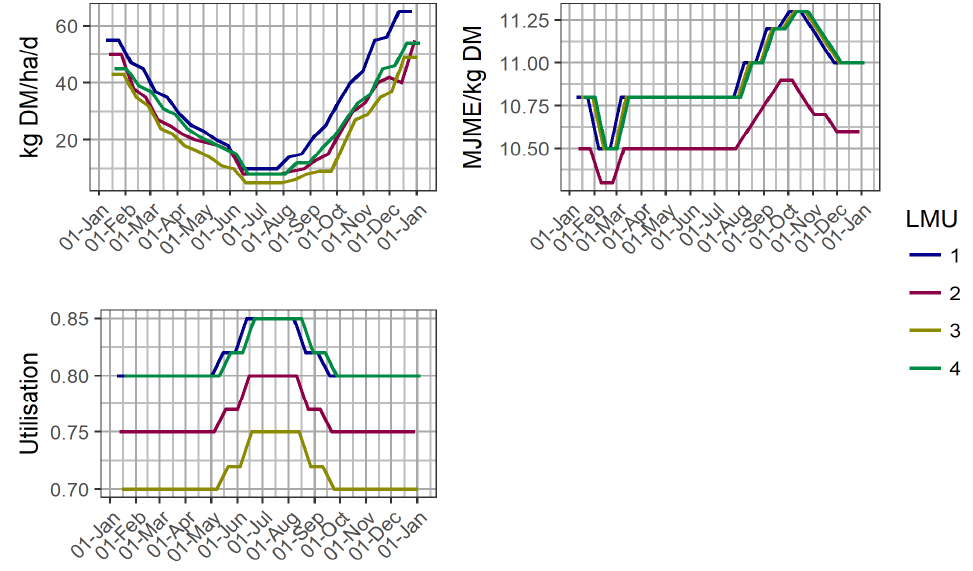
Figure 2. Pasture growth, top left (kg Dry Matter per hectare per day), energy content, top right (mega joules of metabolizable energy per kg DM) and utilisation (0 to 1) for each of the four LMUs in pasture on the farm-level case (Base farm). Utilisation of the feed is defined as the proportion of DM that disappears which is consumed by the animals.